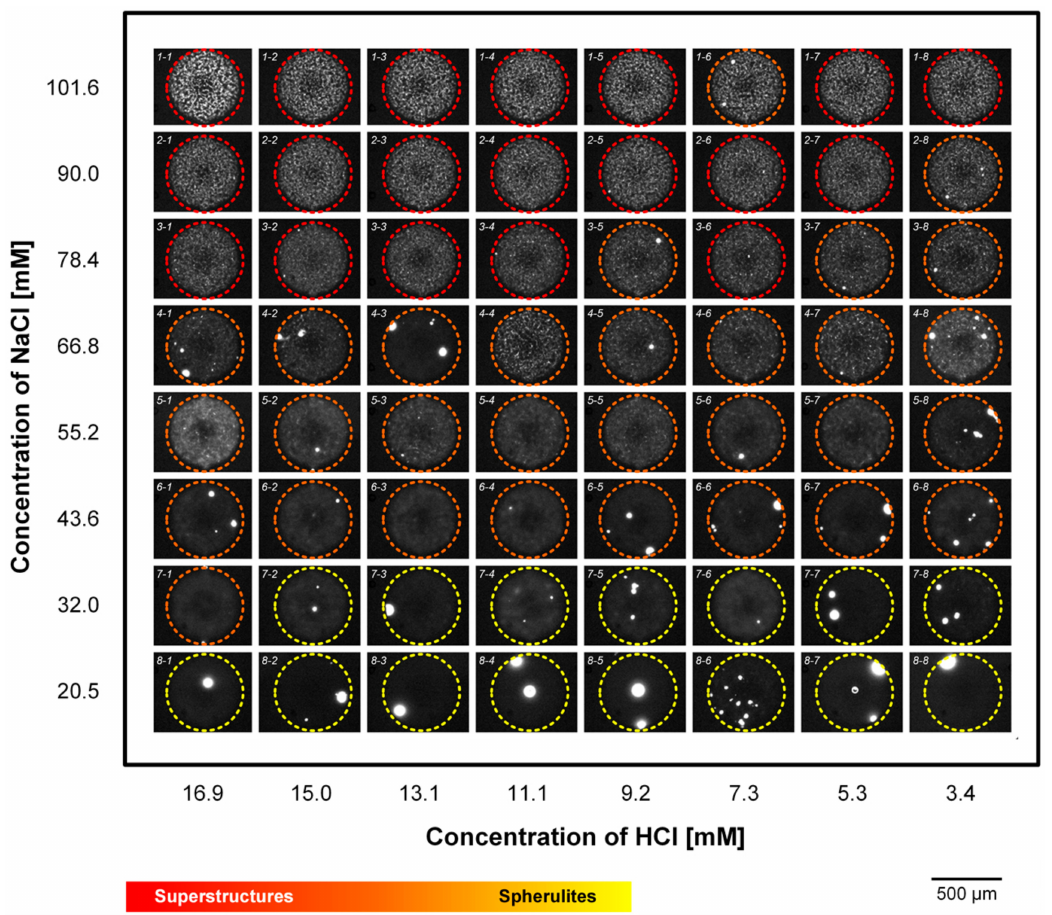
Figure 6. The combined e ff ect of concentrations of NaCl and HCl on insulin fibrillar structure formation after 90 min of